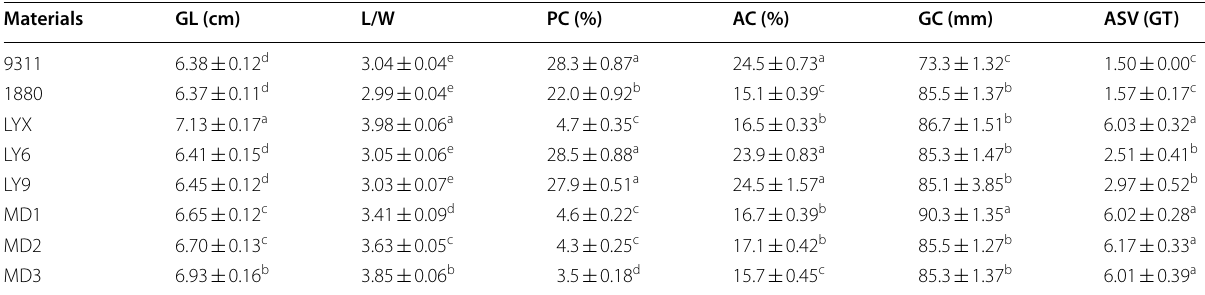
GL Grain length; L / W Length-to-width ratio; PC Percent chalk; AC Amylose content; GC Gel consistency; ASV Alkali spreading value. Values are the means Letters indicate a significant difference at the 5% significance level by the least significant difference test